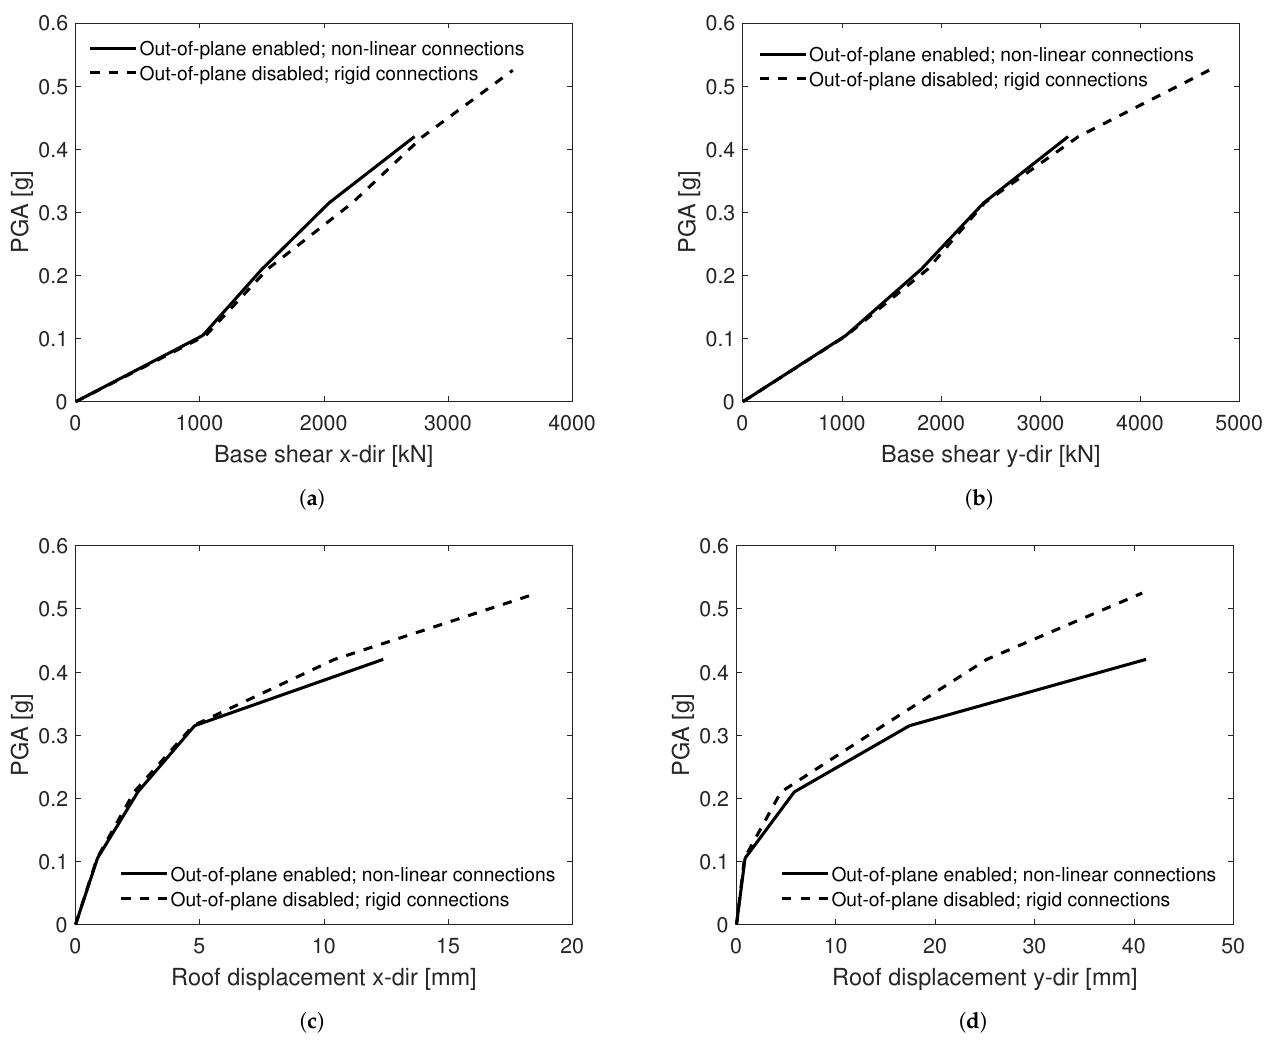
Figure 24. Holsteiner Hof comparison of IDA curves for models with: (i) out-of-plane enabled and non-linear connections, and (ii) out-of-plane disabled and rigid connections, displaying the maximum values of seismic demand parameters: ( a ) Total base shear in x-direction. ( b ) Total base shear in y-direction. ( c ) Average roof displacement in x-direction. ( d ) Average roof displacement in